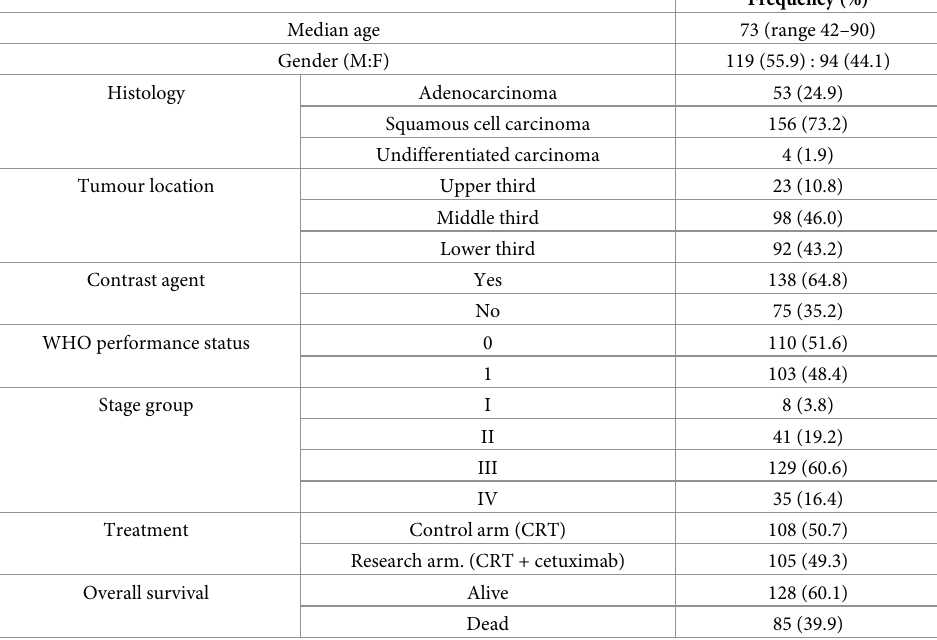
Table 1. Baseline characteristics of the clinical